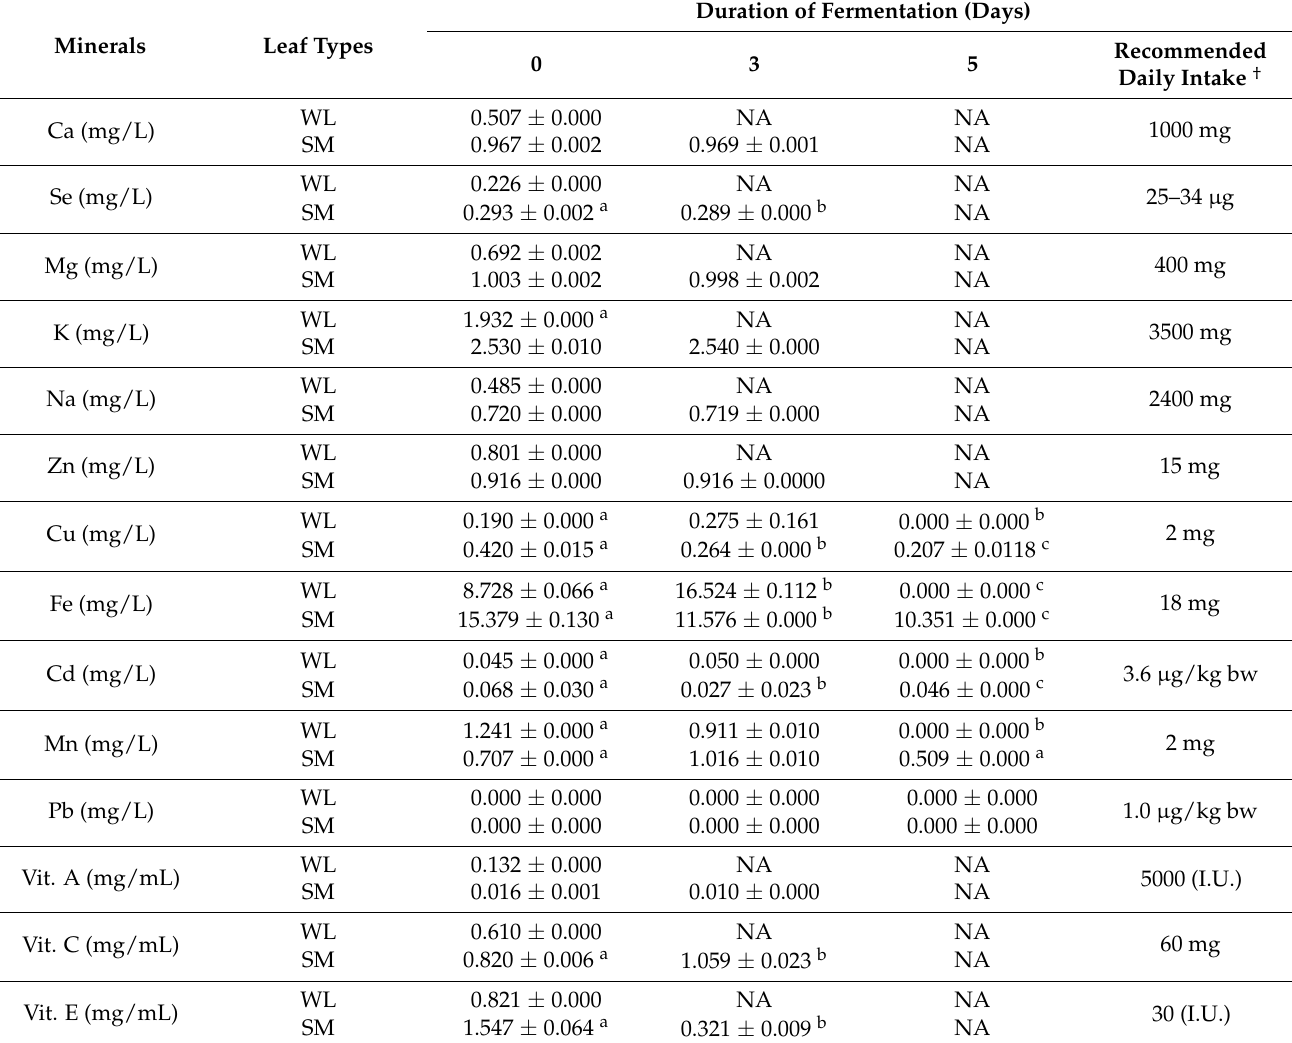
Table 2. Some micronutrients in fermented leave extracts from S. monostachyus and T. fruticosum